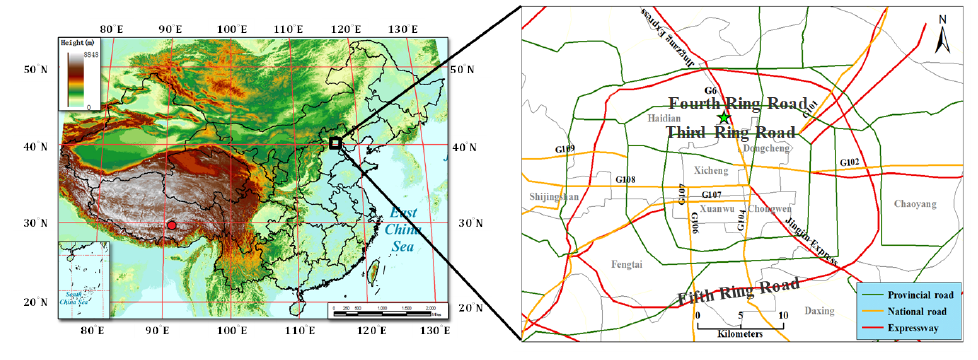
Figure 1. Map with location of the sampling site (the asterisk in the right figure indicates the sampling